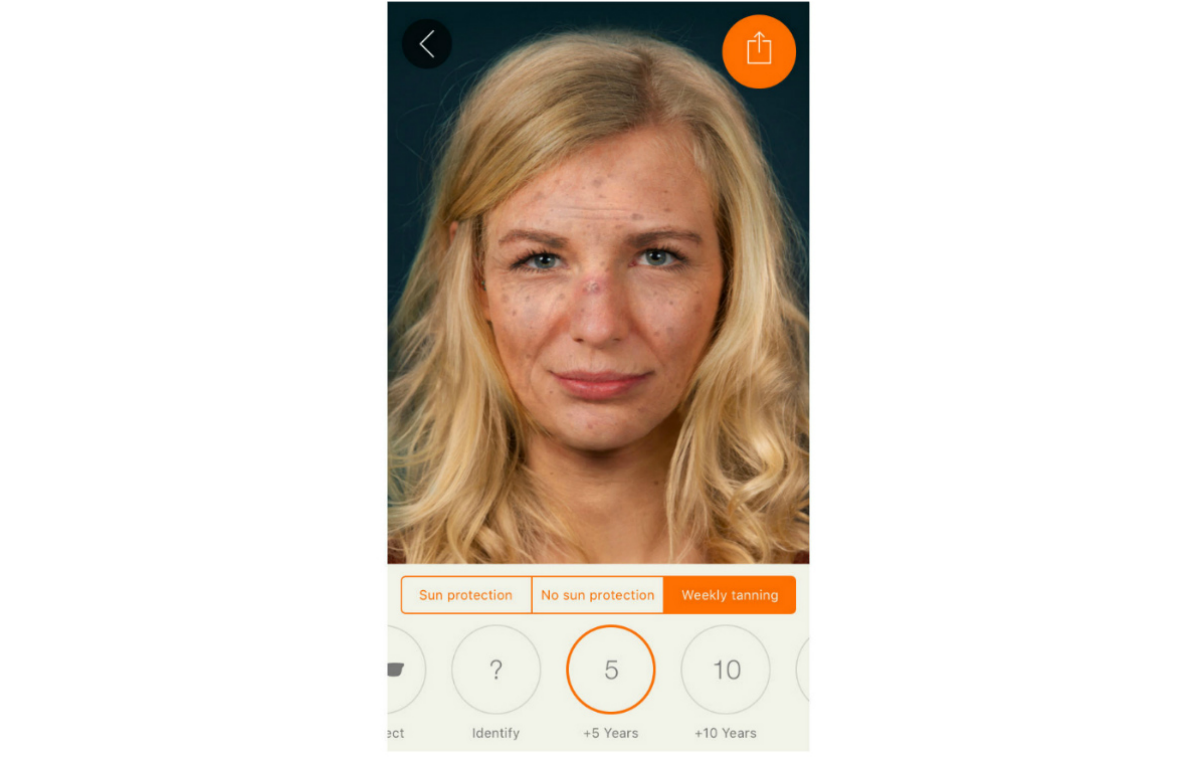
Figure 3. Effect view: 5 years of weekly tanning without sun protection.